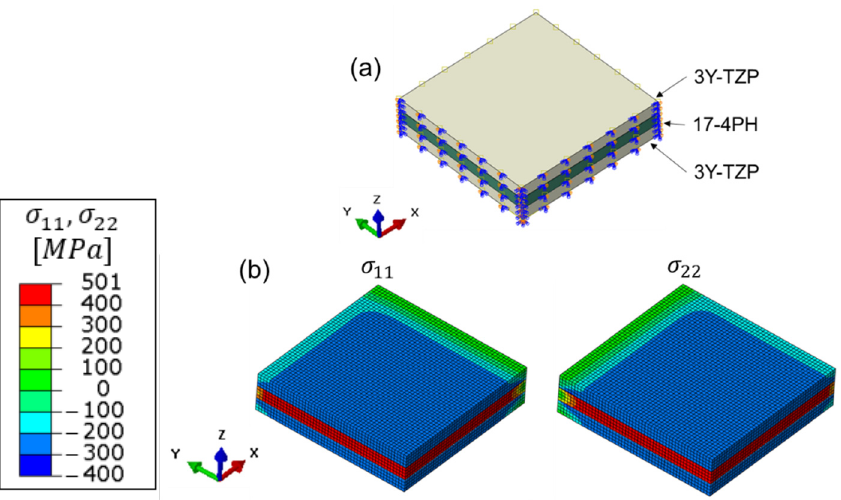
Figure 12. ( a ) The assembly of the three-layer MCLs and the boundary conditions. ( b ) The stress distribution of the three-layer MCLs based on the FE simulation.